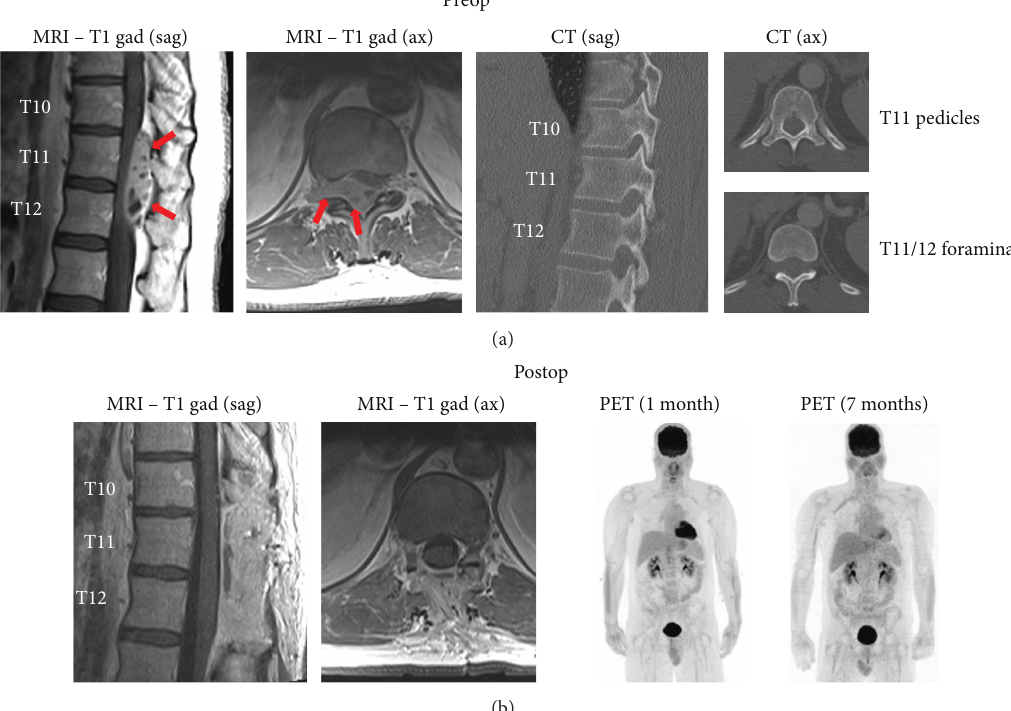
Figure 1: Radiographic findings. (a) Preoperative MRI indicates a heterogeneously enhancing epidural mass (arrows) at T10–12 extending from the spinal canal into the right T11-12 foramen. CT shows that the osseous elements are intact. (b) Postoperative imaging shows T10–12 laminectomies and gross total resection of the lesion. PET imaging 1 and 7 months after resection shows no abnormal FDG uptake. Sag: sagittal, ax: axial, and gad: